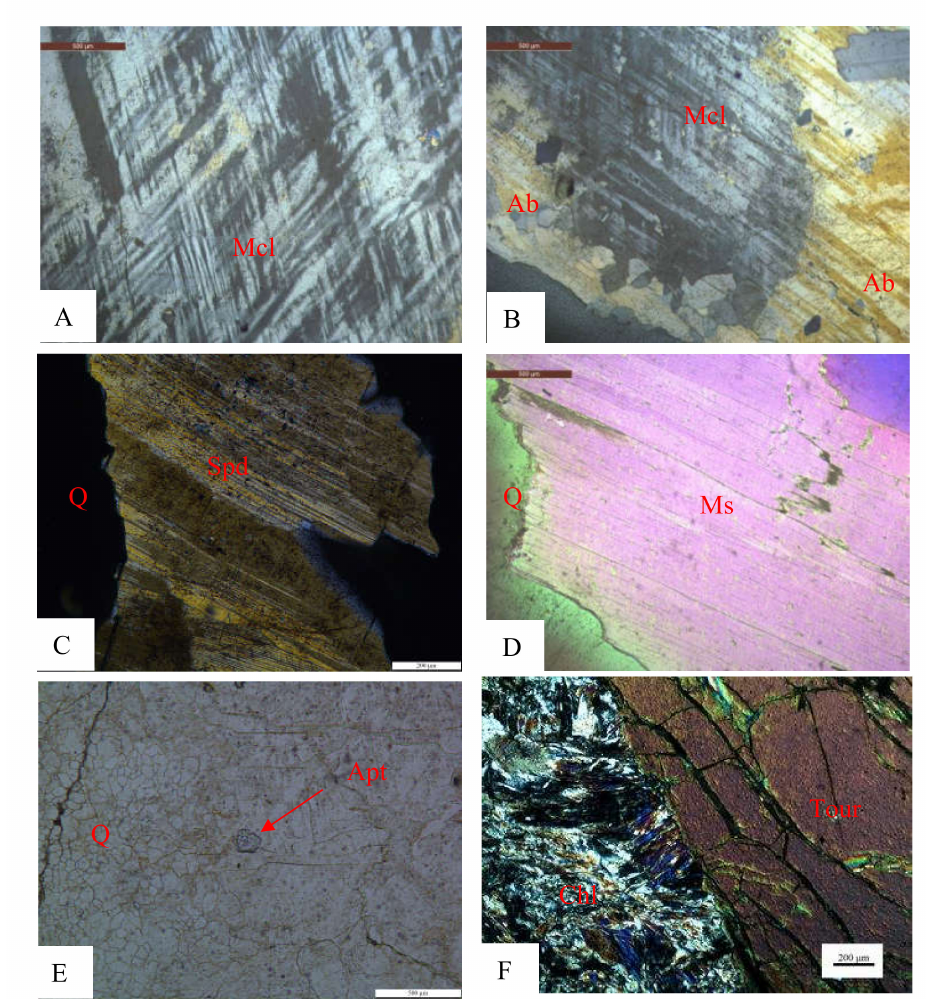
Figure 4. The main minerals in the Lijiapuzi pegmatite deposit (Transmitted cross-polarized light). ( A ) microcline with crossed twinning, with weak alteration; ( B ) albitization of microcline with an irregular contact boundary between them; ( C ) spodumene; ( D ) muscovite, fractured perpendicular to cleavages and filled by late metallic minerals; ( E ) apatite; ( F ) chloritization of plagioclase amphibolites; Mcl-microcline; Ab-albite; Q-quartz; Spd-spodumene; Ms-muscovite; Apt-apatite; Chl-chlorite;